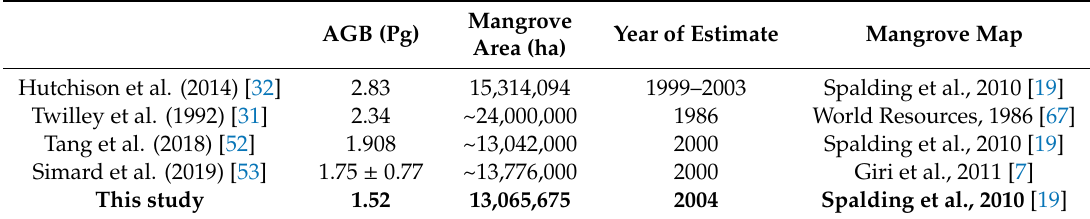
Table 3. Comparison of total mangrove AGB and area with previously published results. Mangrove AGB (Pg) Year of Estimate Mangrove Area (ha)